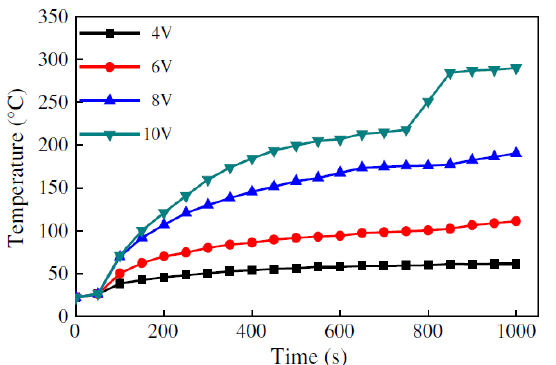
Figure 19. Curves of temperature dependence on different applied voltages at room temperature. Reprinted with permission from [107].